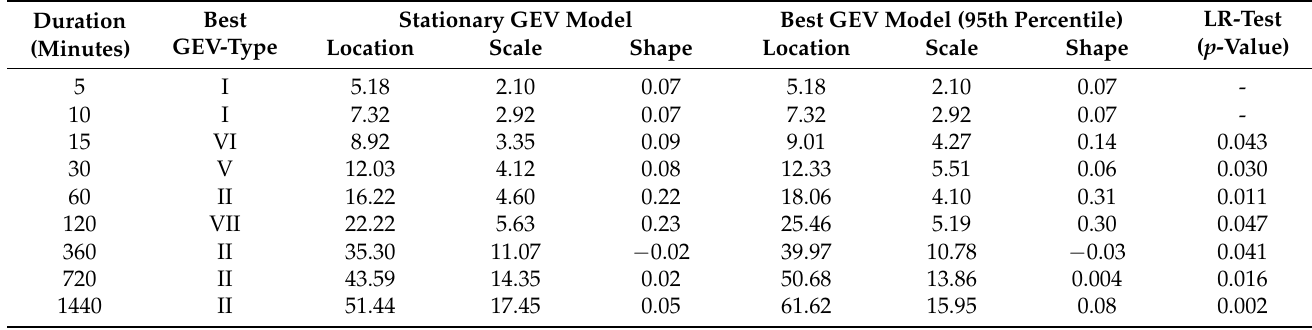
Table 4. Parameters of GEV distribution, in mm, for historical data for the Moncton station.